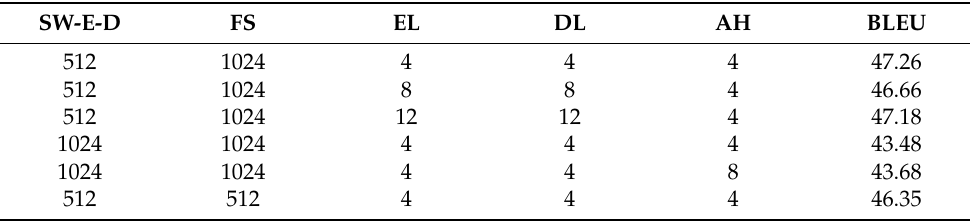
Table 4. Results of the Transformer-Based NMT Subword Model on MADAR–Gulf corpus for GULF– MSA translation task, where SW-E-D is the Subword embedding dimension, FS is the filter size, EL is the encoder layer, DL is the decoder layer and AH is the attention heads